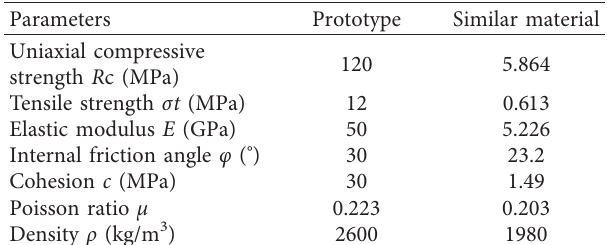
Figure 2: The schematic diagram of the static loads applied to the test sample. Table 1: Physical and mechanical parameters of similar materials and prototype of intact